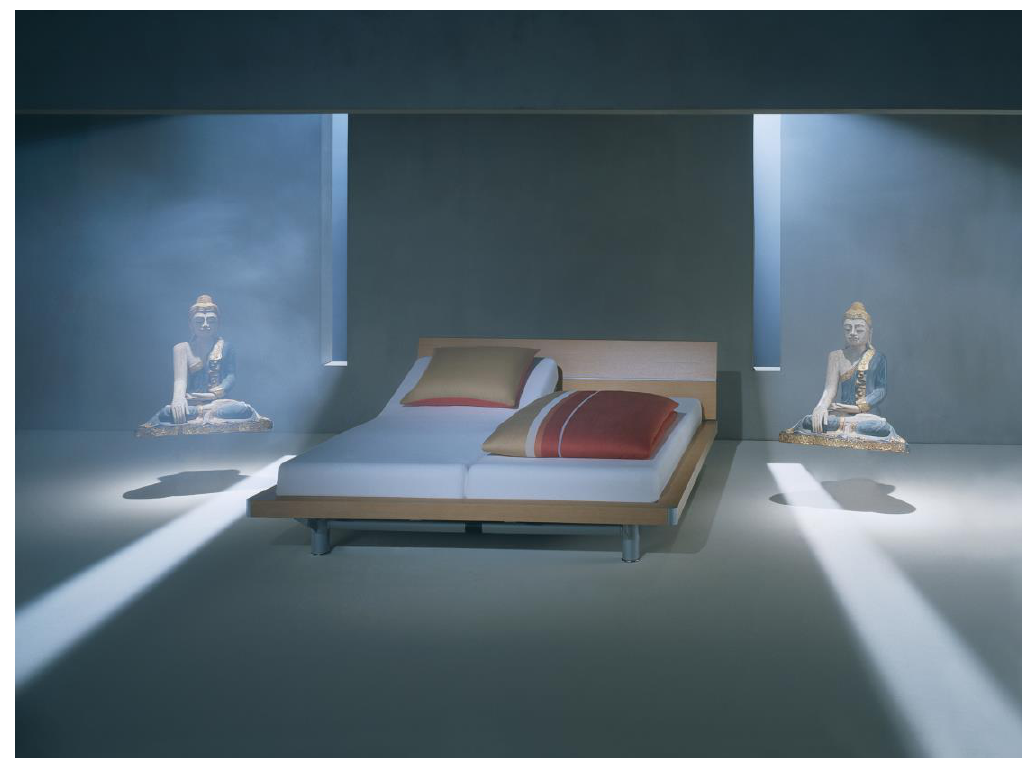
Figure 3: Buddha branding futons. Reproduced with